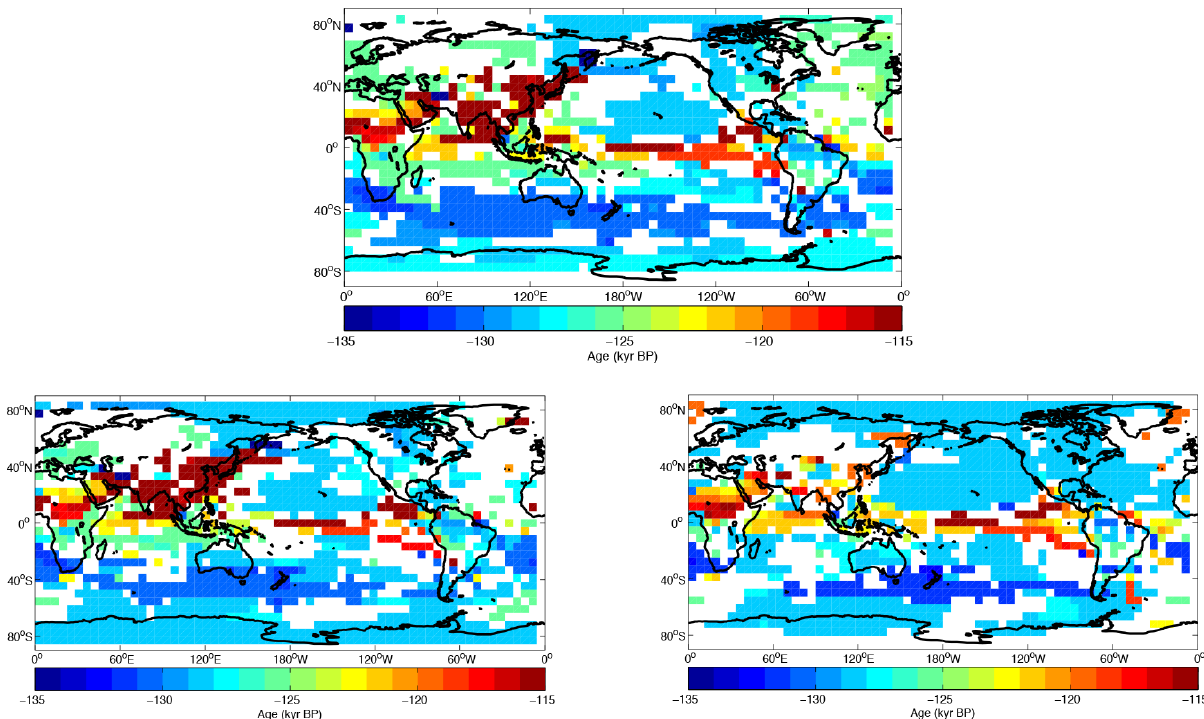
Figure 14. Timing (in kyr) of the simulated LIG surface temperature maximum (MWT) in annual mean for (a) parLR, (b) allLR and (c)